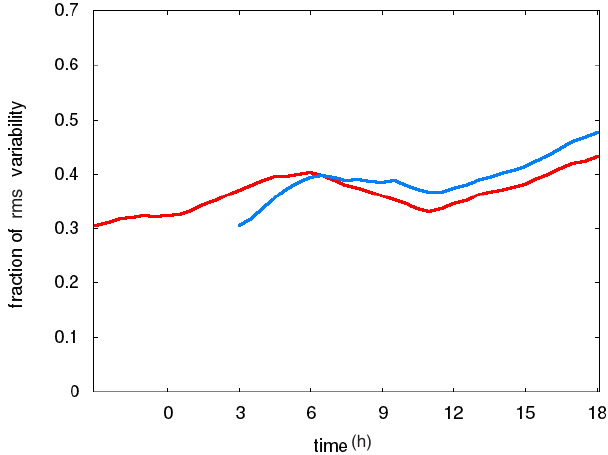
Figure 8. Red: rms error evolution of the 18H control trajectory, same as in Fig. 1. Blue: error of the trajectory restarted after sub- traction of the orthogonal error component on the 12 bred vectors’ subspace. Times indicated on the x axis correspond to UTC times on 26 September